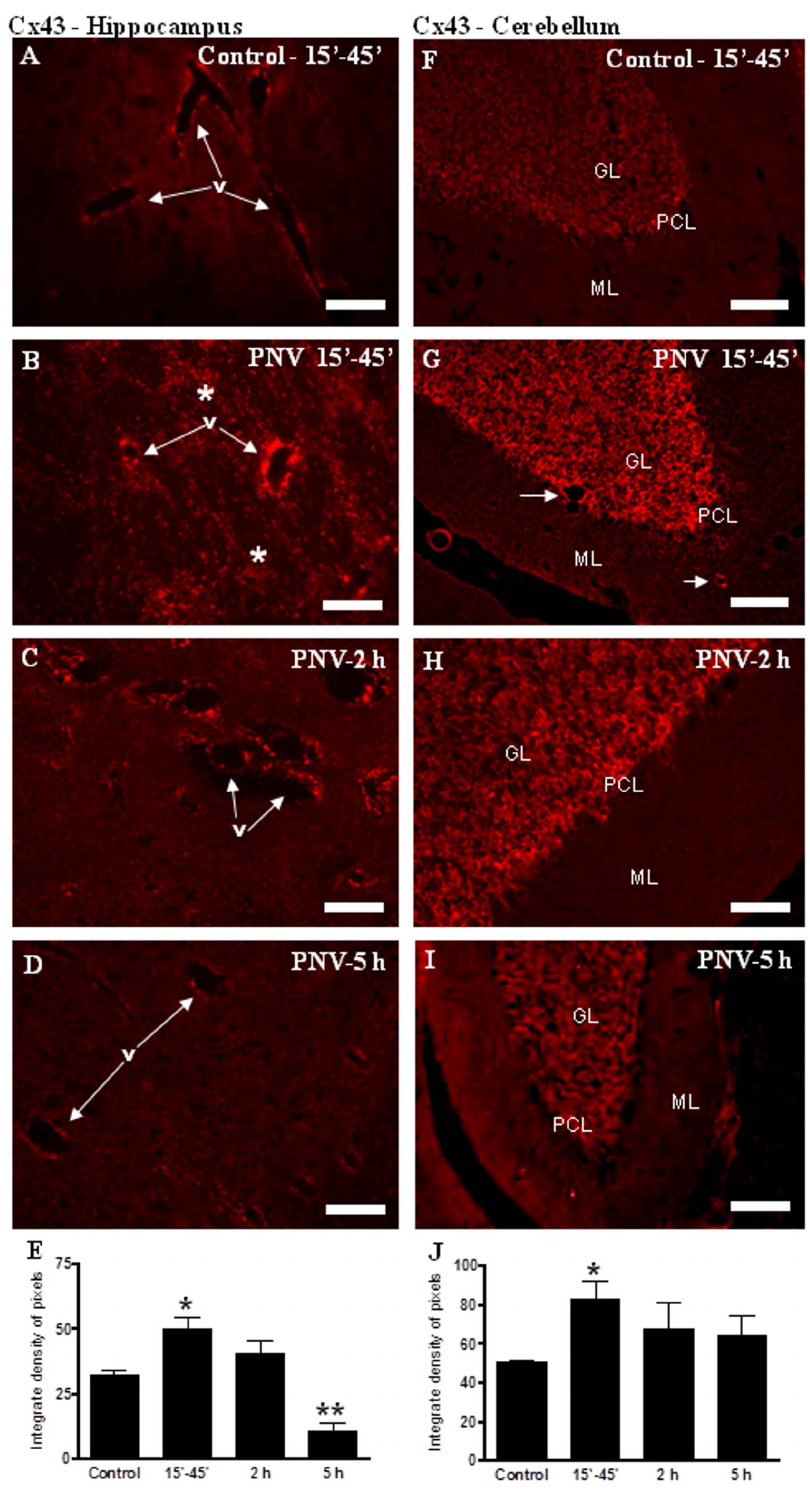
Figure 6. Immunofluorescence (IF) for Cx43 in hippocampus (A–D) and cerebellum (F–I). Cx43 expression was increased after 15–45 9 in the hippocampus and cerebellum. In the hippocampus, there was an intense decrease after 5 h of envenoming. E and J show the IF densitometric values for hippocampus and cerebellum, respectively (*p , 0.05, **p , 0.01 compared to control). Values represent the mean 6 S.E.M. The results were confirmed in three sets of experiments. v= blood vessel; *= labeled parenchyma; GL – glomerular layer; ML – molecular layer; PCL = Purkinje cell layer. Bars =70 m m (A–D, F, G, I); 35 m m (H).